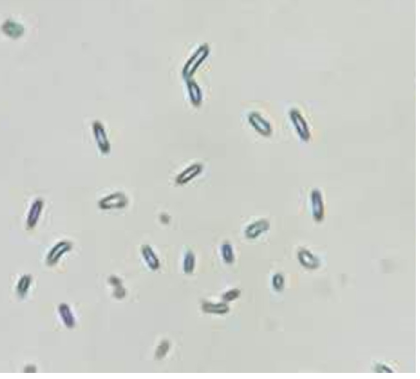
Figure 4: Microscopic morphology of blank niosomes ( 1,000 ×) .